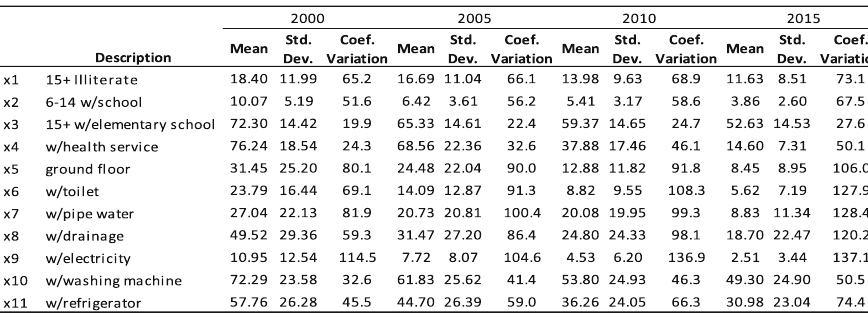
Table 1 Descriptive statistics of the social lag variables